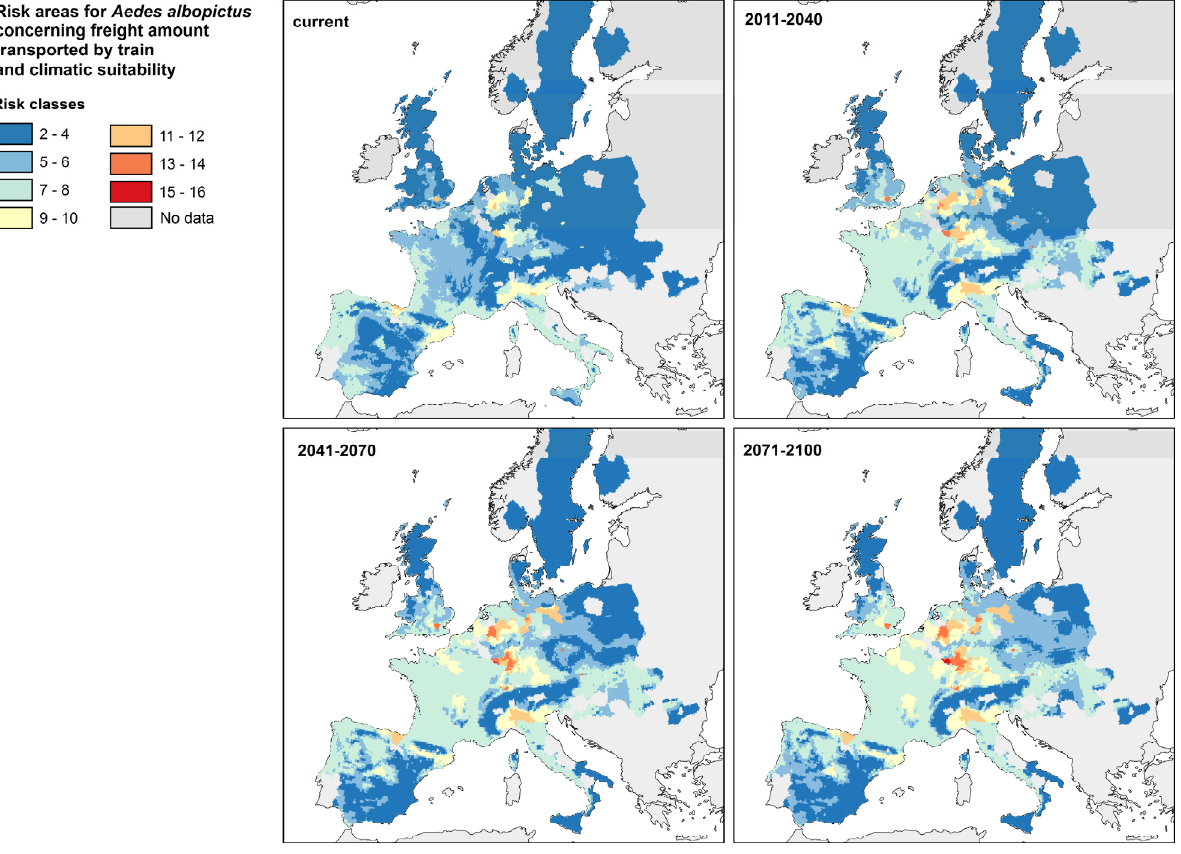
Figure 5. Risk for the establishment of Aedes albopictus by taking into account both, the amount of freight imports from the mosquito’s endemic countries via harbors/railways and the climate suitability of the recipient regions for mosquito’s long-term